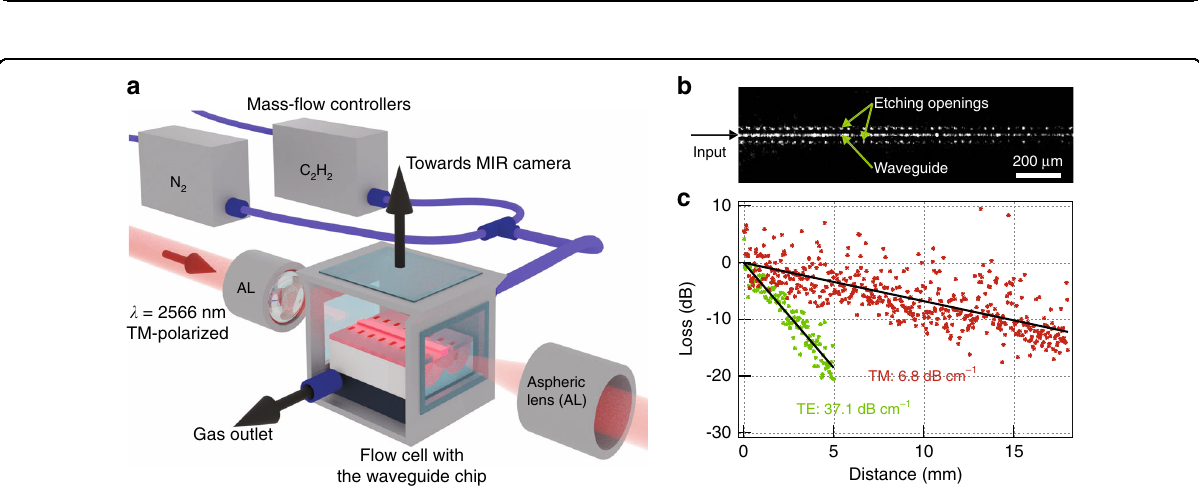
Fig. 3 Characterization setup and propagation loss measurement. a Outline of the experimental setup. b Top-view MIR image of the waveguide at 2.566 µm. The guided mode is visible through out-of-plane scattering at waveguide roughness and imperfections. c Propagation loss determined from the decay of out-of-plane scattered light for both TM and TE polarizations. The TE mode that is well con fi ned in the Ta 2 O 5 membrane experiences higher loss due to material absorption than the strongly delocalized TM